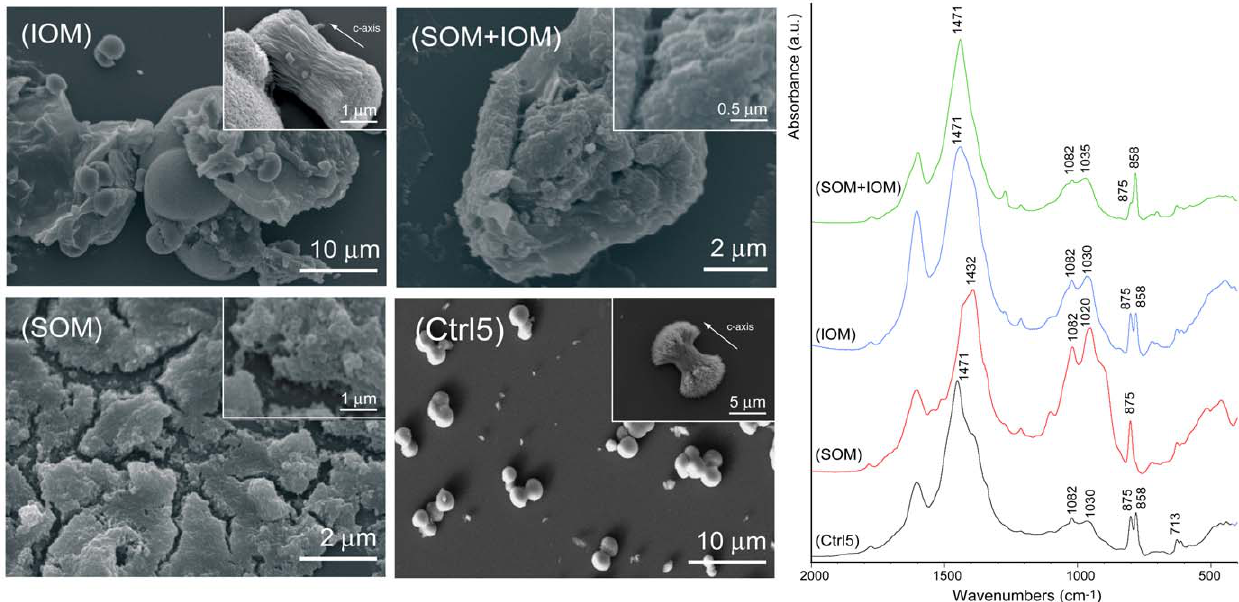
Figure 7. Calcium carbonate crystallization experiments. Crystallization experiments of calcium carbonate from 10 mM CaCl 2 solution with a Mg/Ca molar ratio equal to 5 (Ctrl5) and in the presence of soluble organic matrix (SOM), insoluble organic matrix (IOM) or both additives (IOM + SOM). The direction of the crystallographic c -axis of aragonite is indicated. left Scanning electron microscope images, the insets show samples details right FTIR spectra of the precipitated. The main absorption bands of calcium carbonate are indicated.